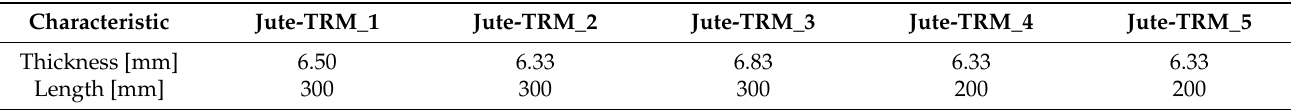
Table 2. Geometric characteristics of Jute-TRM.